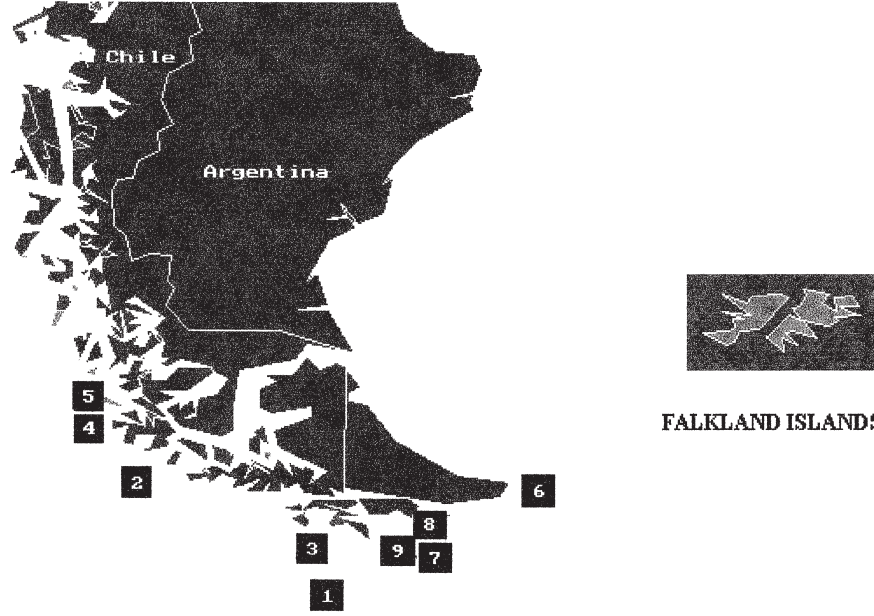
F IG . 5. – Map of Macaroni Penguin breeding sites (numbers refer to